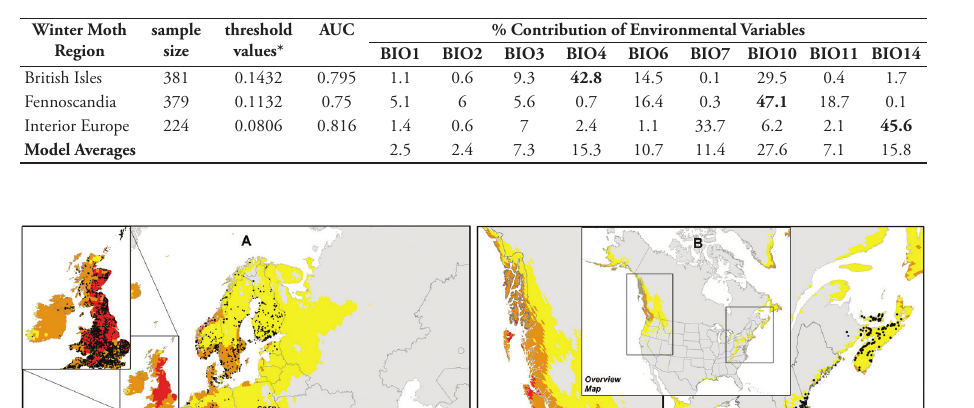
Table 2. Model results for each spatial bin. Percent contribution of environmental variables are in bold for those variables that showed the highest model gain in isolation; values highlighted in gray represent the most information not present in other variables, and * denotes balance threshold used for classified maps which seeks to balance training omission, predicted area and threshold value cloglog threshold.